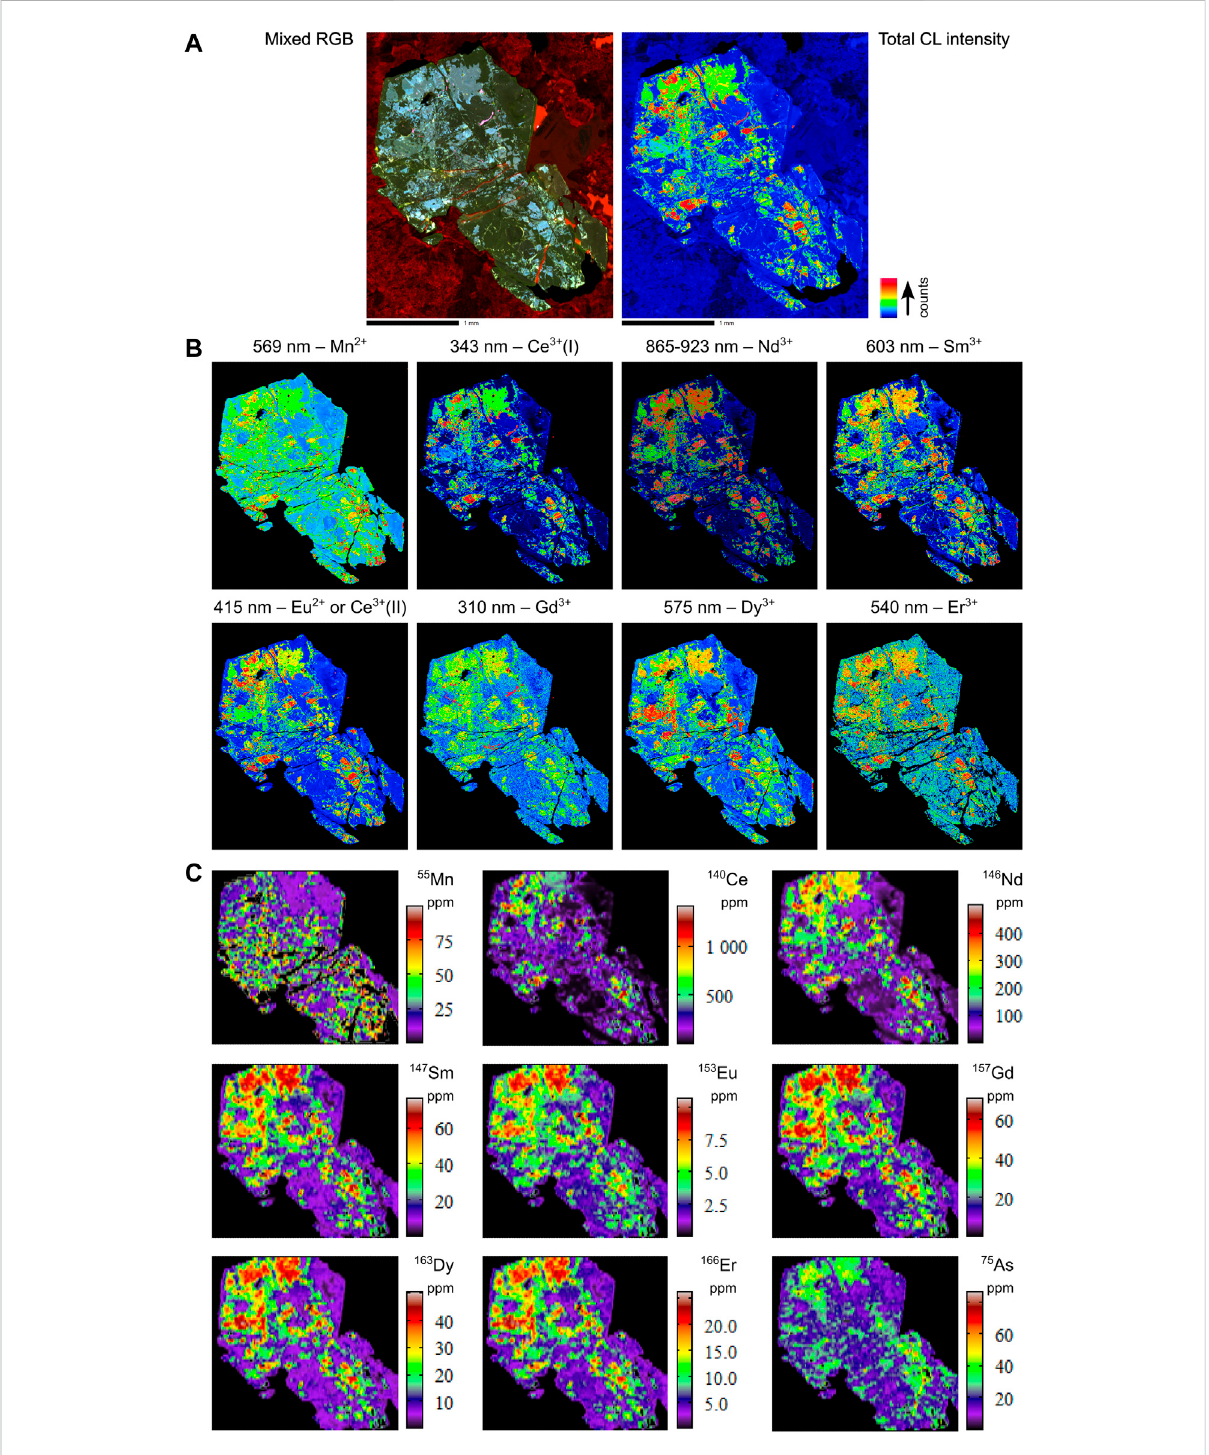
FIGURE 7 Combined hyperspectral CL and LA-ICPMS images of selected elements for sample EHMT1-1479.1. (A) Total CL intensity and mixed RGB images. (B) Hyperspectral CL images. (C) LA-ICPMS